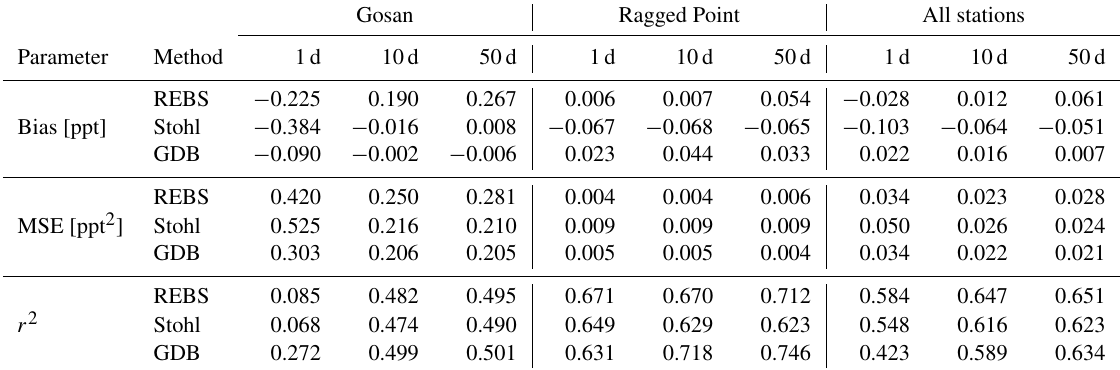
Table 2. Bias, mean squared error (MSE), and coefficient of determination ( r 2 ) of a priori SF 6 mixing ratios determined by the three investigated baseline methods with respect to observed mixing ratios. Statistical parameters are shown for three different backward calculation periods (1, 10, and 50d) at the stations Gosan and Ragged Point. Also reported are the bias, MSE, and r 2 , calculated separately for all stations listed in Table 1 and then